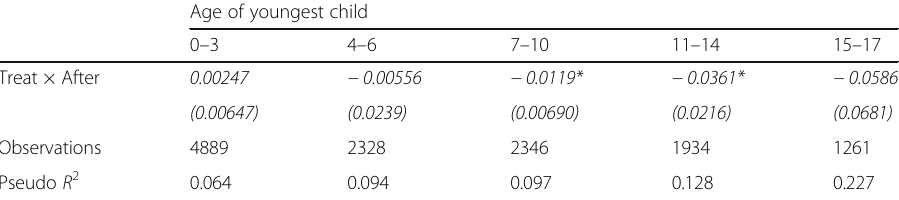
Table 9 Effect of AUH on the probability of entering the labor force. Heterogeneities: age of youngest child Age of youngest child 0 – 3 4 – 6 7 – 10 11 – 14 15 – 17 Treat × After 0.00247 − 0.00556 − 0.0119*